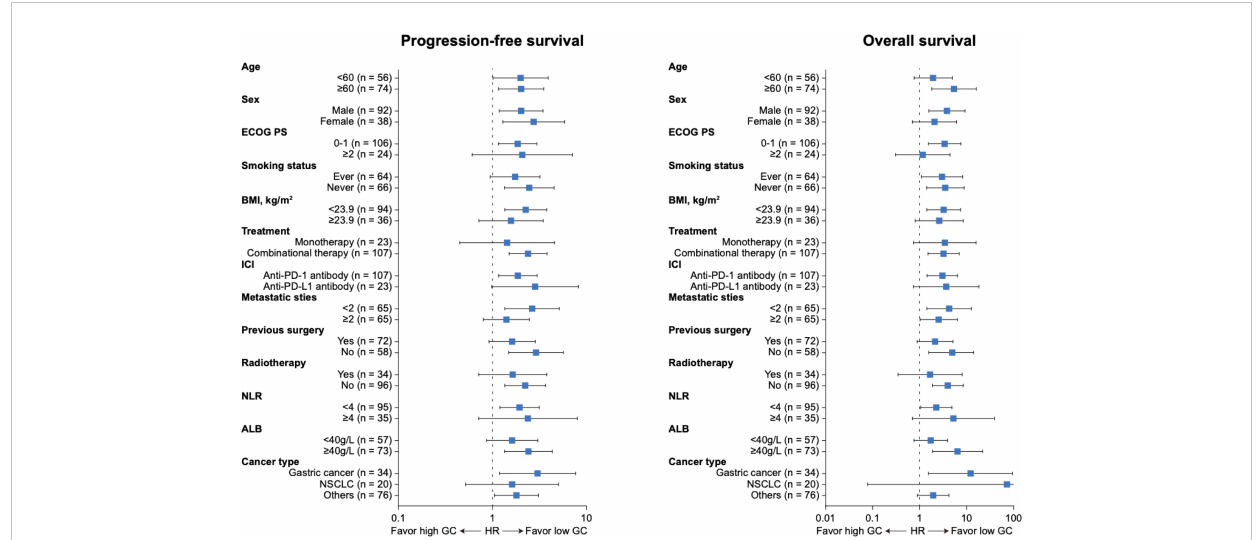
FIGURE 4 Forest plot of subgroup analyses of prognostic factors for progression-free survival and overall survival in patients with high endogenous GC levels versus low endogenous GC levels. ECOG, Eastern Cooperative Oncology Group; HR, hazard ratio; PS, performance status; GC, glucocorticoid; PD-1, programmed cell death-1; PD-L1, programmed death ligand 1; BMI, body mass index; ALB, albumin; NLR, neutrophil to lymphocyte